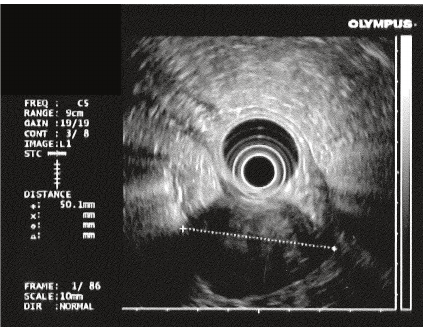
Figure 3: Endoscopic ultrasonogram: a 5 cm hypoechoic inhomo- geneous mass lesion with calcification is seen. The mass appears to arise from the muscularis propria.